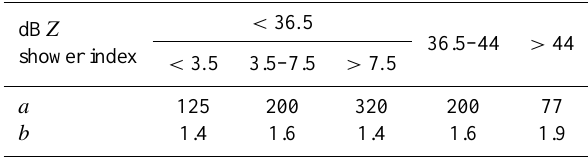
Table 2. Table of rain gauges used in this study. Table 3. Table containing the values of a and b used for the conver- sion of radar reflectivity Z to rain rate R with R = aZ b according to findings of the RADOLAN project. Overestimation of convective precipitation and underestimation of stratiform precipitation shall be avoided by distinguishing precipitation types from the reflectiv- ity values (in dB Z ) and a shower index for each pixel. The later is the mean value of the absolute differences in reflectivity of the neighbouring pixels (Bartels et al.,